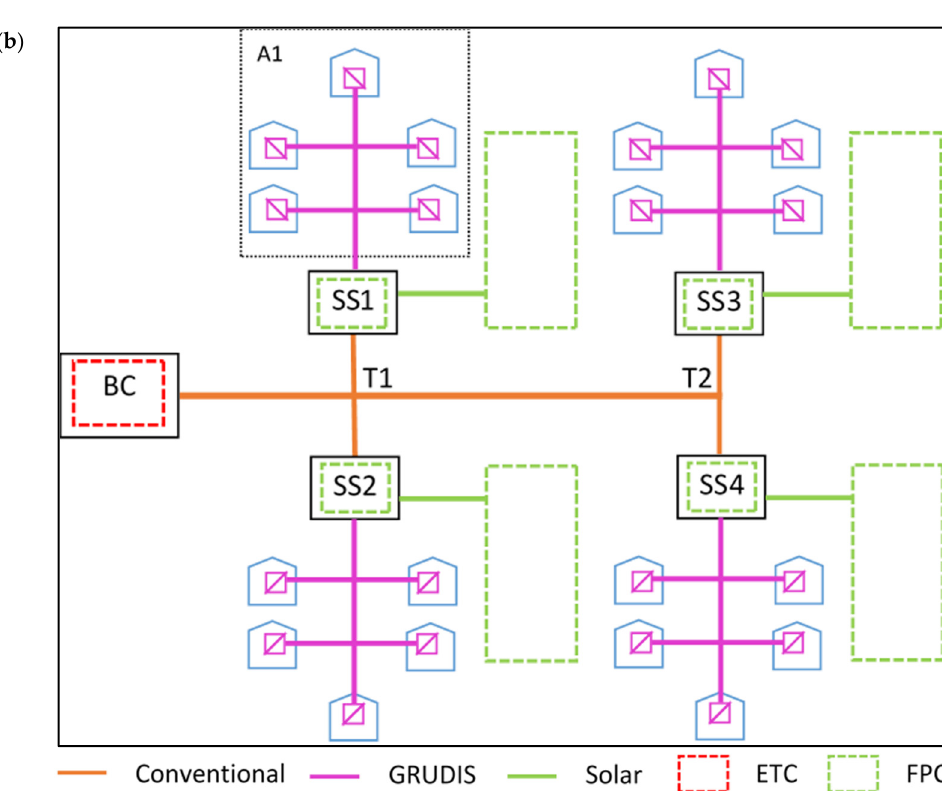
Figure 2. System layout—schematics of ( a ) GRUDIS network and ( b ) hybrid network. Evacuated tube collectors (ETC) are located on the boiler central (BC), and flat plate collectors (FPC) are located on either intermediate substation (SS) and/or ground [12].